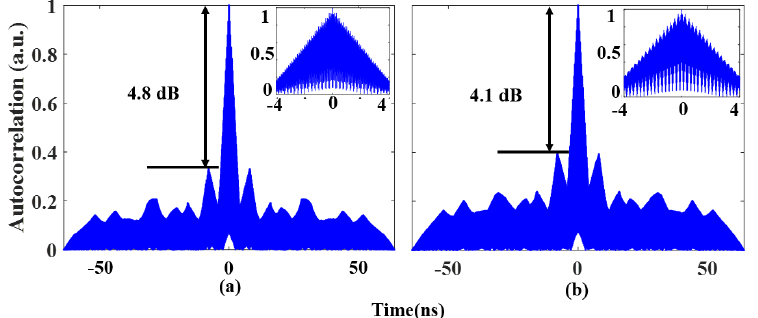
Figure 11. Autocorrelation results of quaternary phase-coded signals in the ( a ) fundamental carrier frequency mode and ( b ) doubled carrier frequency mode. The insets show zoomed–in views of the corresponding autocorrelations.